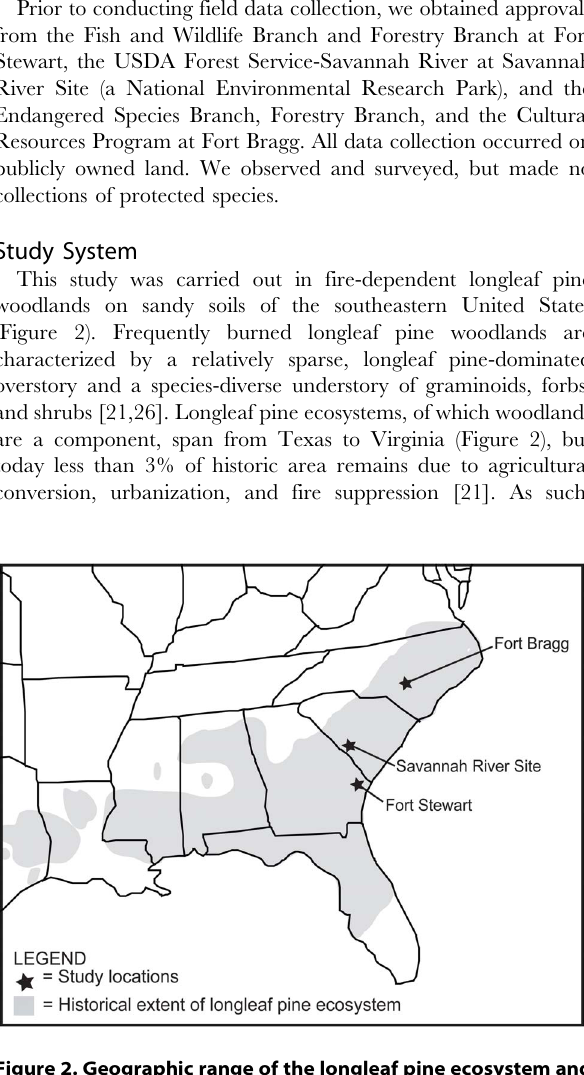
Figure 2. Geographic range of the longleaf pine ecosystem and map of study locations. Study locations (Fort Bragg [NC], 31 u 11’ N, 79 u 15’ W; Fort Stewart [GA], 31 u 56’ N, 81 u 36’ W; and Savannah River Site [SC], 33 u 20’ N, 81 u 40’ W) were in three different physiographic regions (sandhills, southern coastal plain, and Atlantic coastal plain, respectively [26]) allowing for creation and evaluation of an ecological reference model across a range of ecological settings. This model was based on data from 232 sites, which varied in their levels of degradation, with results subsequently compared to data from 38 reference sites.